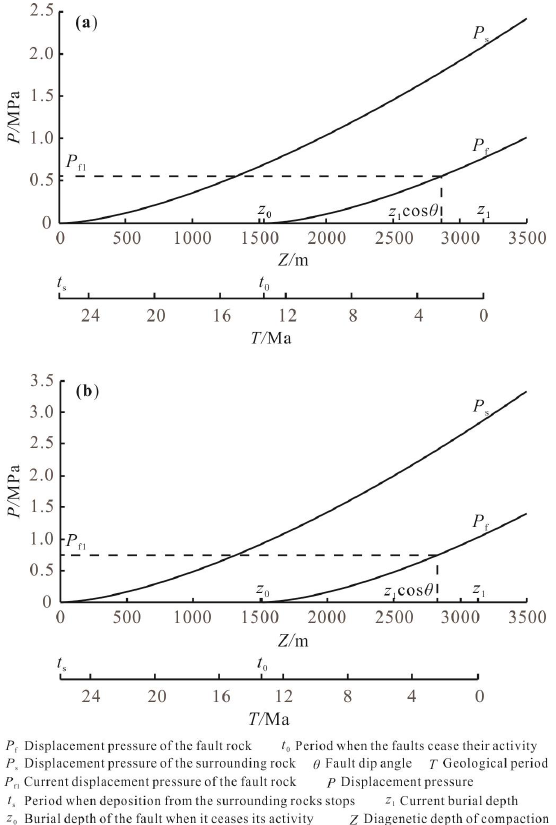
Figure 7. Determination of displacement pressures of the fault rocks at survey lines ( a ) L2 and ( b ) L8.